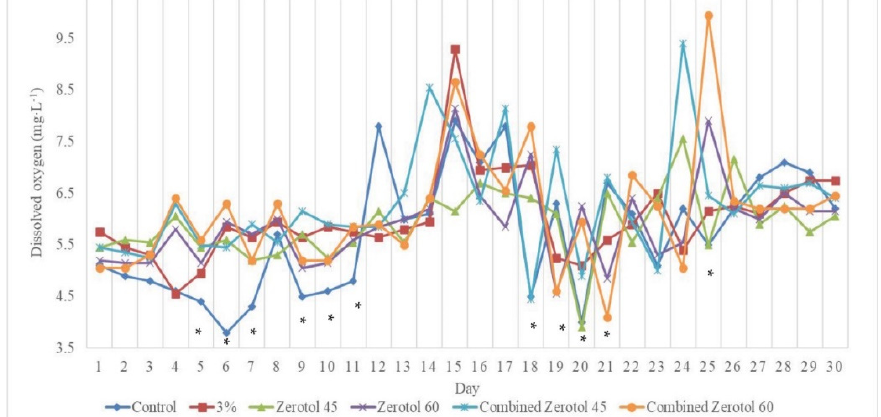
Figure 2. Effects of the rate of two hydrogen peroxide products, ZeroTol (Z) and 3% hydrogen peroxide (3%) (45 mL Z, 60 mL Z, 45mL Z, and 50 mL 3%, and 60 mL Z and 50 mL 3%) on dissolved oxygen (DO) levels of nutrient solution in ebb and flow hydroponic systems at OSU research greenhouses in Stillwater, OK. Treatments were applied weekly starting on day three. Stars show significant differences between at least two treatments that day for experiment one.